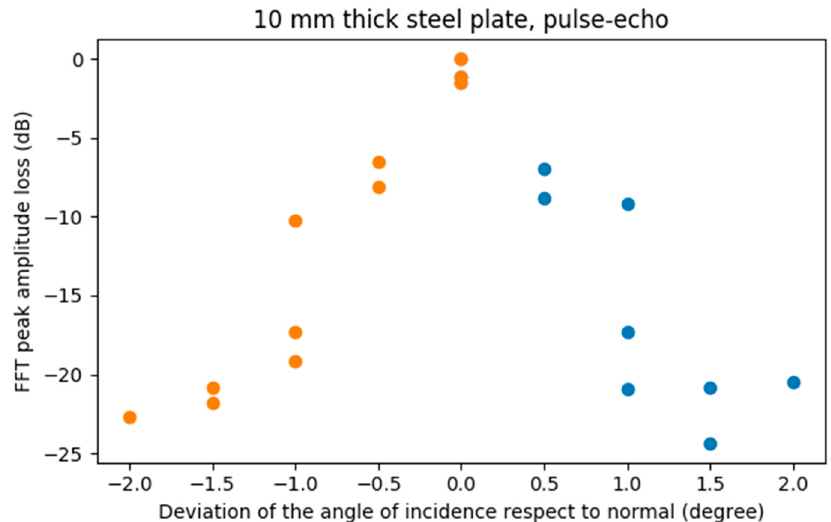
Figure 13. FFT peak loss in dB (compared with normal incidence peak amplitude) vs. deviation of the angle of incidence away from normal incidence for the 10 mm-thick stainless steel plate. The 14 ms window located at t 0 = 6 ms.